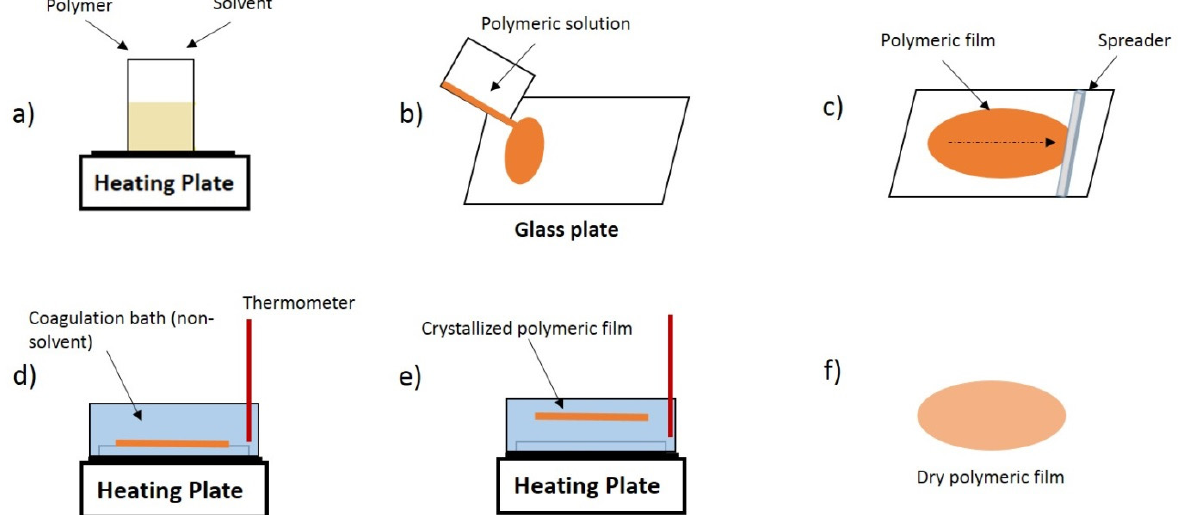
Figure 1. Schematic representation of the sample preparation steps by non-solvent induced phase separation (NIPS): ( a ) polymer dissolution, ( b ) solution spreading, ( c ) solution casting, ( d ) immersion in the coagulation bath, ( e ) phase inversion and ( f ) membrane drying.